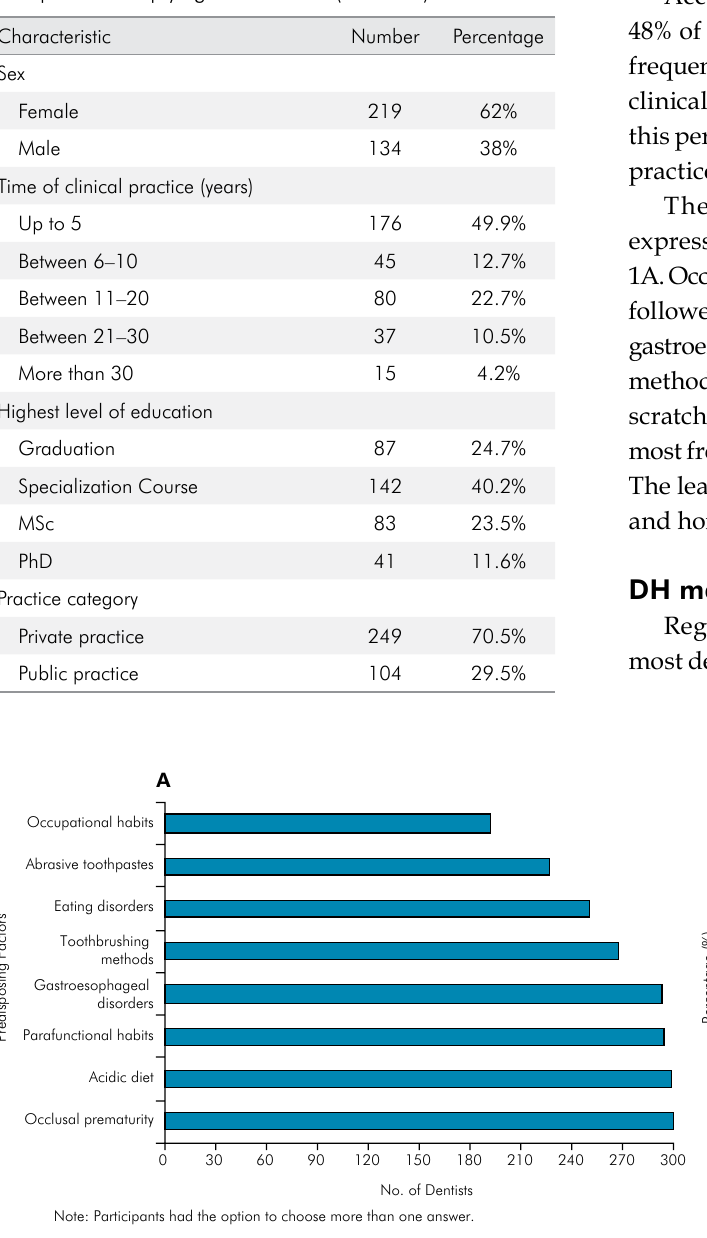
Table 1. Personal and practice characteristics of Brazilian dentists participating in the study, by number and percentage of respondents replying to each item (n = 353).